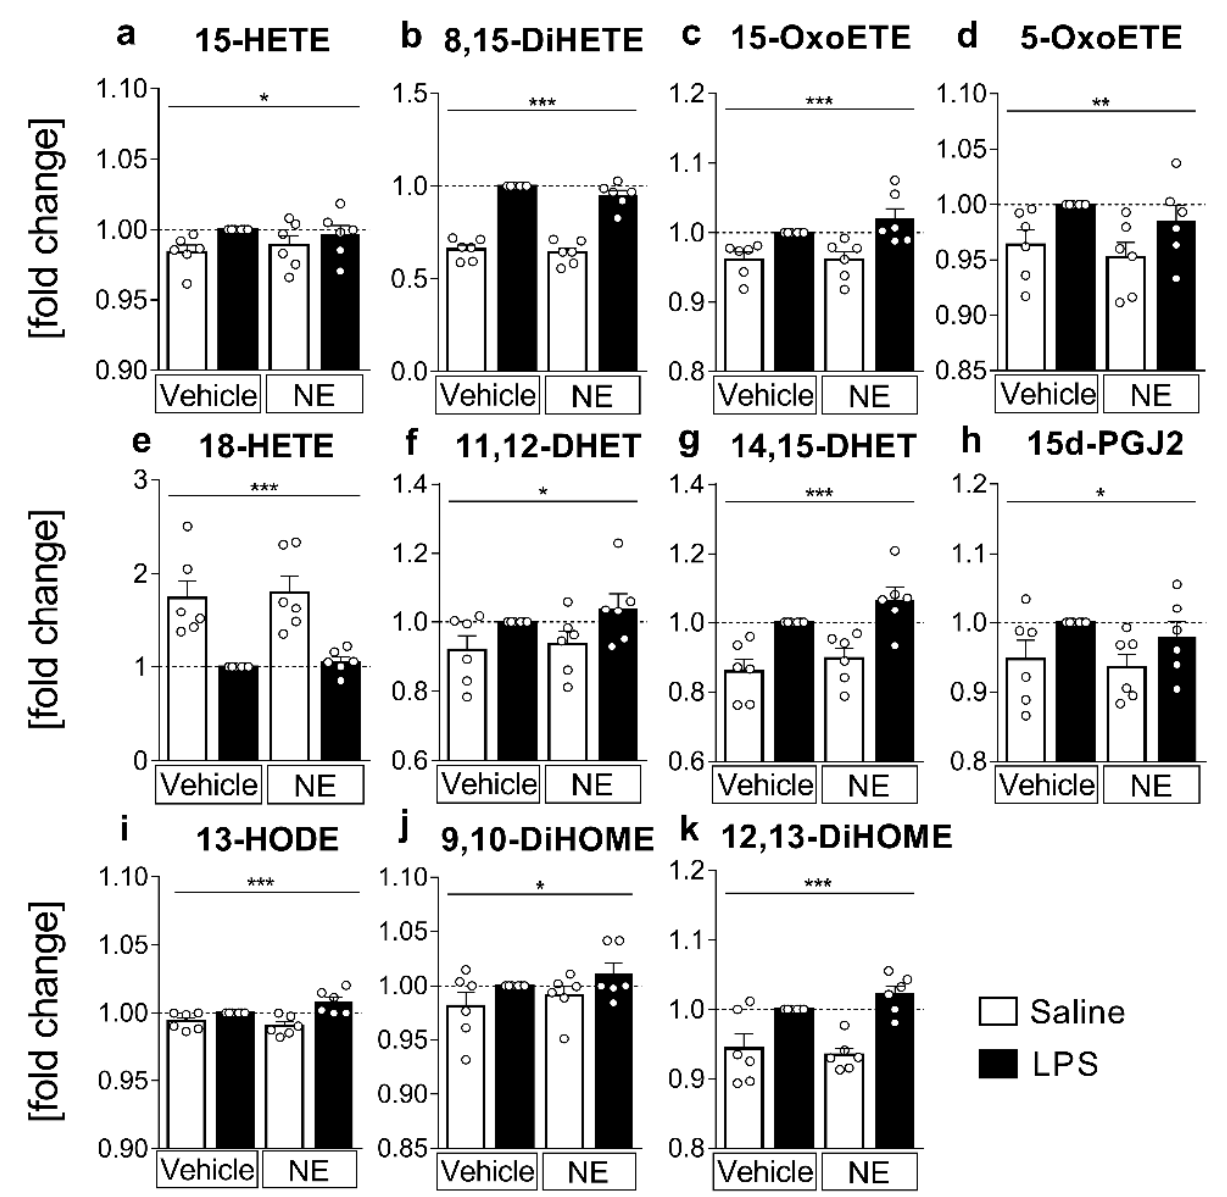
Figure 3. n-6 lipid mediators and metabolites from supernatants: detection and quantification of n-6 lipid mediators and metabolites derived from arachidonic acid (AA) ( a – h ) or linoleic acid (LA) ( i – k ) from supernatants using LC-MS/MS. Primary sensory circumventricular organ (sCVO) cell cultures were stimulated with lipopolysaccharide (LPS 10 µ g/mL) or saline and simultaneously treated with norepinephrine (NE, 1 µ mol/L) or vehicle for 4 h. For every sample set, metabolite concentrations are plotted as fold change to the LPS-stimulated sample (LPS+vehicle) for each of the six independent experiments. AA-derived metabolites elevated in LPS-stimulated samples: ( a ) 15-HETE (hydroxy-eicosatetraenoic acid); ( b ) 8,15-DiHETE (dihydroxy-eicosatetraenoic acid), ( c ) 15-OxoETE (oxo-eicosatetraenoic acid); ( d ) 5-OxoETE; ( f ) 11,12-DHET (dihydroxy-eicosatrienoic acid); ( g ) 14,15-DHET; ( h ) 15d-PGJ2 (15-Deoxy-Delta-12,14-prostaglandin-J2); ( e ) 18-HETE was reduced in LPS-stimulated samples. LPS-induced LA metabolites showed higher levels in supernatants compared to controls: ( i ) 13-HODE (hydroxy-octadecadienoic acid); ( j ) 9,10-DiHOME (dihydroxy- octadecenoic acid); ( k ) 12,13-DiHOME; n = 6 per group, two-factorial ANOVA, Bonferroni post hoc test, * main effect LPS stimulation, * p < 0.05, ** p < 0.01, *** p < 0.001.